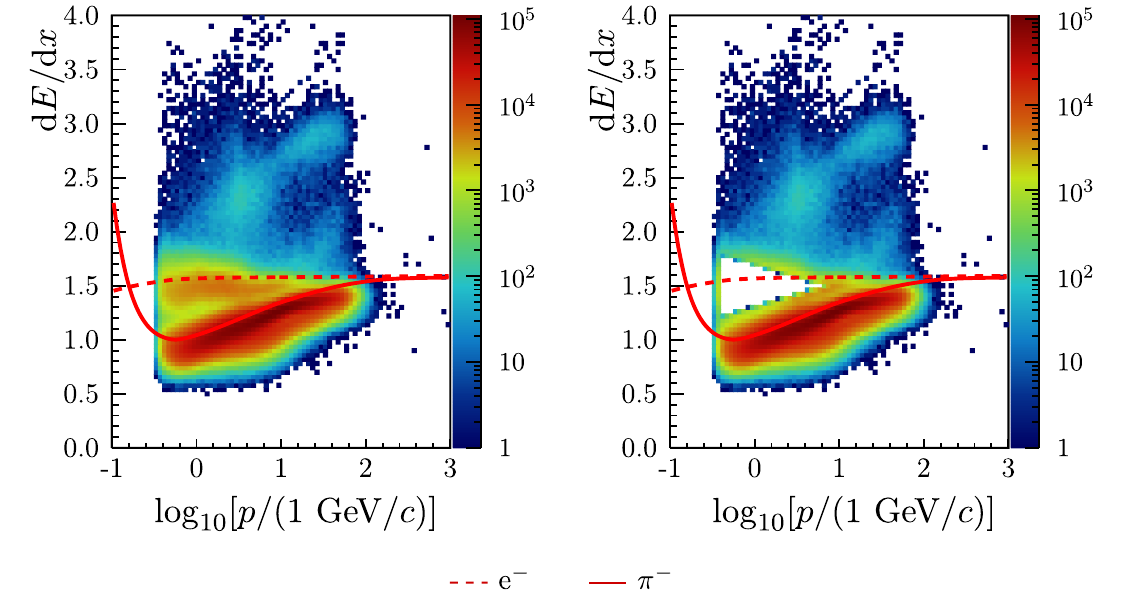
Fig. 6 2D histograms of specific energy loss d E /dx versus momentum in Ar+Sc interactions at 150 A GeV / c before ( left ) and after ( right ) electron exclusion. The Bethe-Bloch functions for electrons and negatively charged pions are plotted by dashed and solid lines,